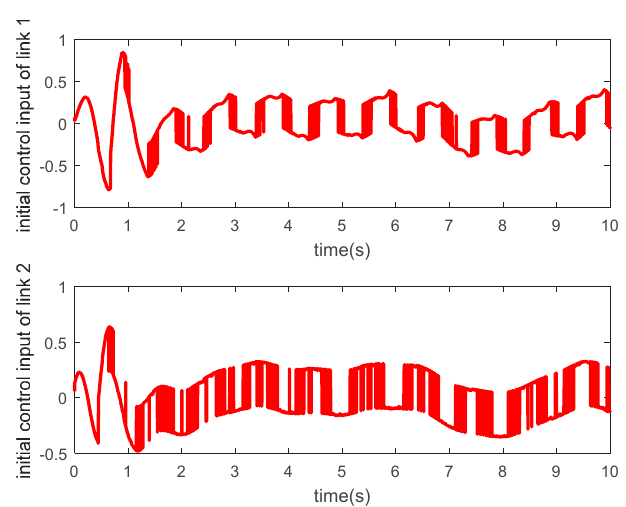
Figure 11. Angular velocity tracking of joints 1 and 2.